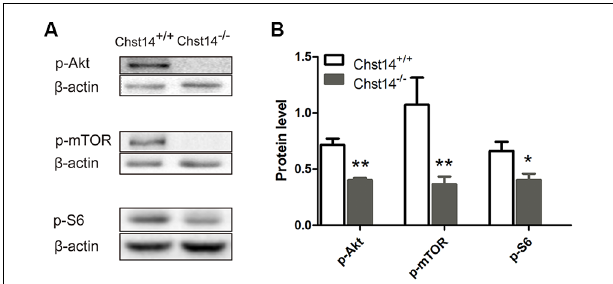
FIGURE 4 | Chst14/D4st1 deficiency reduces the protein expression of Akt/mammalian target rapamycin (mTOR) signaling pathway in the hippocampus. Total proteins from WT or Chst14 − / − mice hippocampi were subjected to Western blot analysis to determine the protein levels of p-Akt, p-mTOR and p-S6. (A,B) Representative immunoblots and densitometric analysis of the immunoblots showed that the expression levels of p-Akt, p-mTOR and p-S6 in the hippocampi were significantly decreased in the Chst14 − / − mice. ∗ p < 0.05, ∗∗ p <